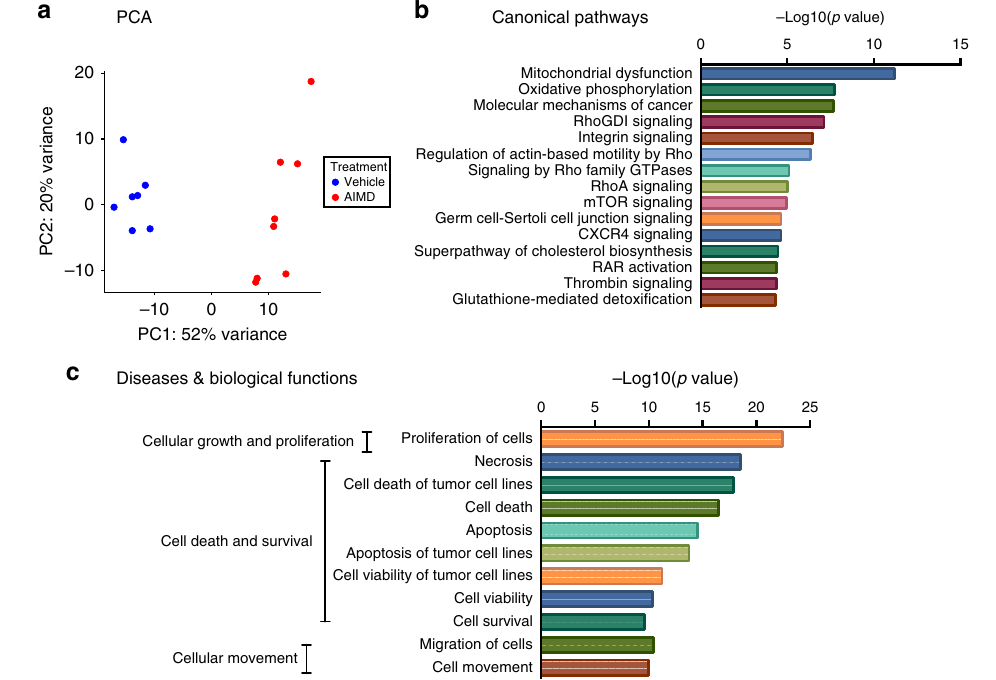
Fig. 5 AIMD induces major changes in the transcriptome of the cecum. a PCA analysis of the cecum RNA-sequencing data ( n = 7/8/groups). b , c Functional annotation of differentially expressed genes using IPA. The top 15 canonical pathways ( b ) and the top 11 biological functions ( c ) are